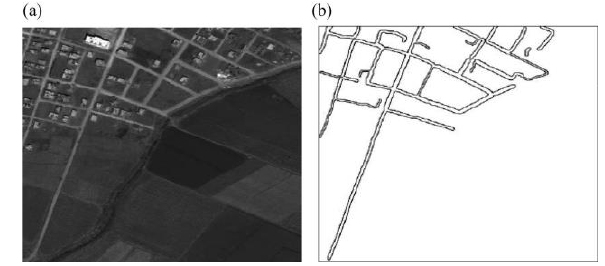
Figure 6. Road detection by Cem algorithm. (a) Ikonos image. (b) Road network detected.